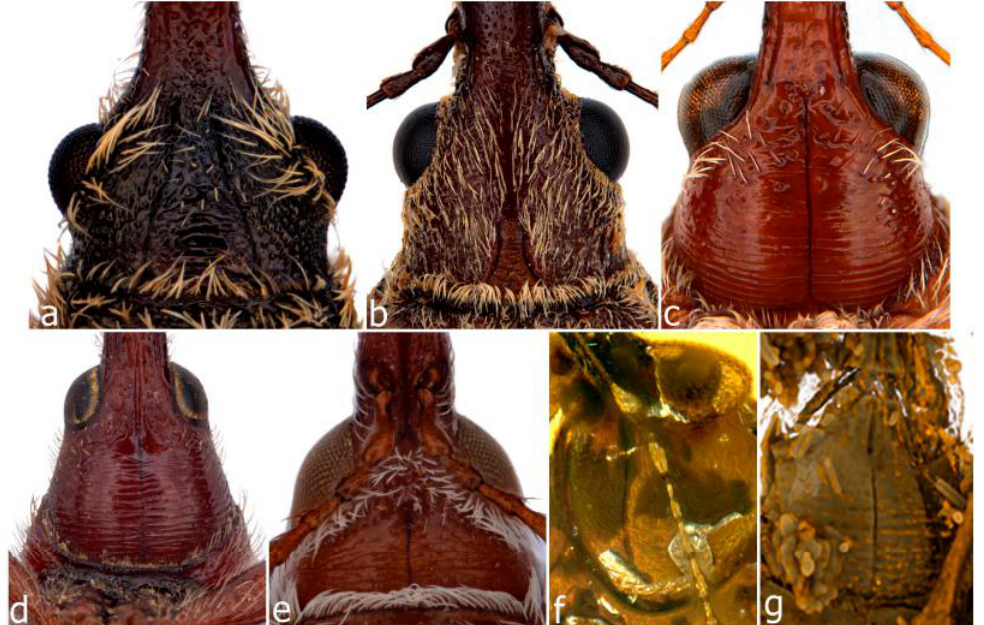
Figure 6. Gular sutures in extant and Burmese amber weevils. Long paired sutures, Cimberis elongata (Cimberididae) ( a ); short paired sutures, Hadrobelus undulatus (Belidae) ( b ); long single suture, Rhodocyrtus cribripennis (Attelabidae) ( c ); long single suture confluent with subgenal sutures, Merhynchites bicolor (Attelabidae) ( d ); short single suture, Car pini (Caridae) ( e ); long single suture, Elwoodius conicops (Mesophyletidae) ( f ); long single suture beneath surface, Petalotarsus oxycorynoides (Mesophyletidae) ( g ).